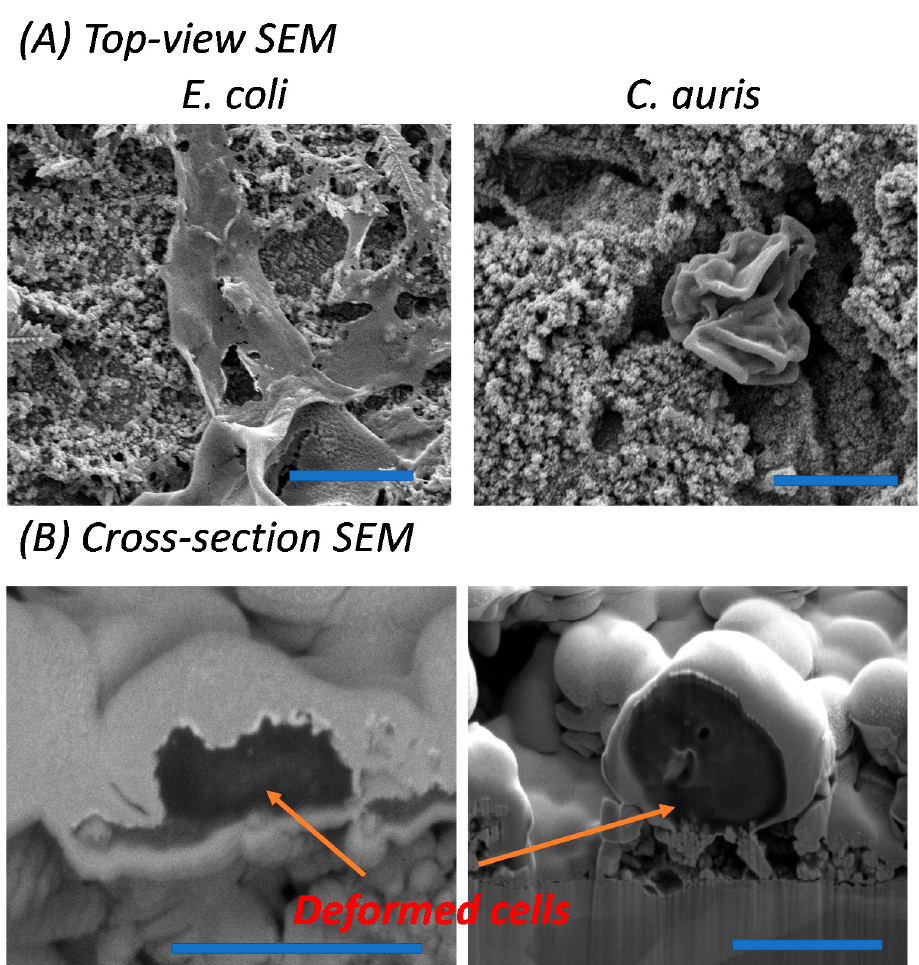
Figure 3. Morphology of E. coli and C. auris on control and Ag NPs-Cu surfaces (Scale bar 5 µm). ( A ) Top-view SEM micrographs showing the cell deformation under the Ag NP clusters (scale bar 5 µm). ( B ) SEM cross-sections using FIB-SEM reveal the interfacial interaction between cell surfaces and nanostructures (left scale bar 1 µm; right scale bar 4 µm).